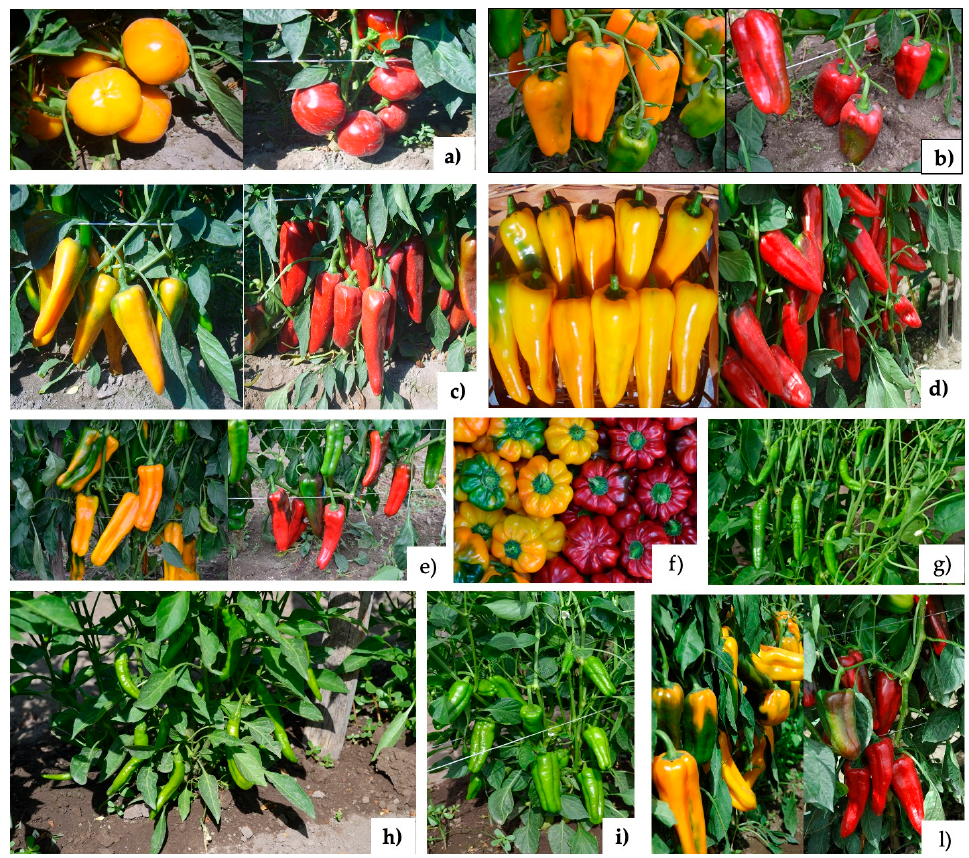
Figure 1. Traditional sweet pepper varieties of the Campania region analyzed in the present work.